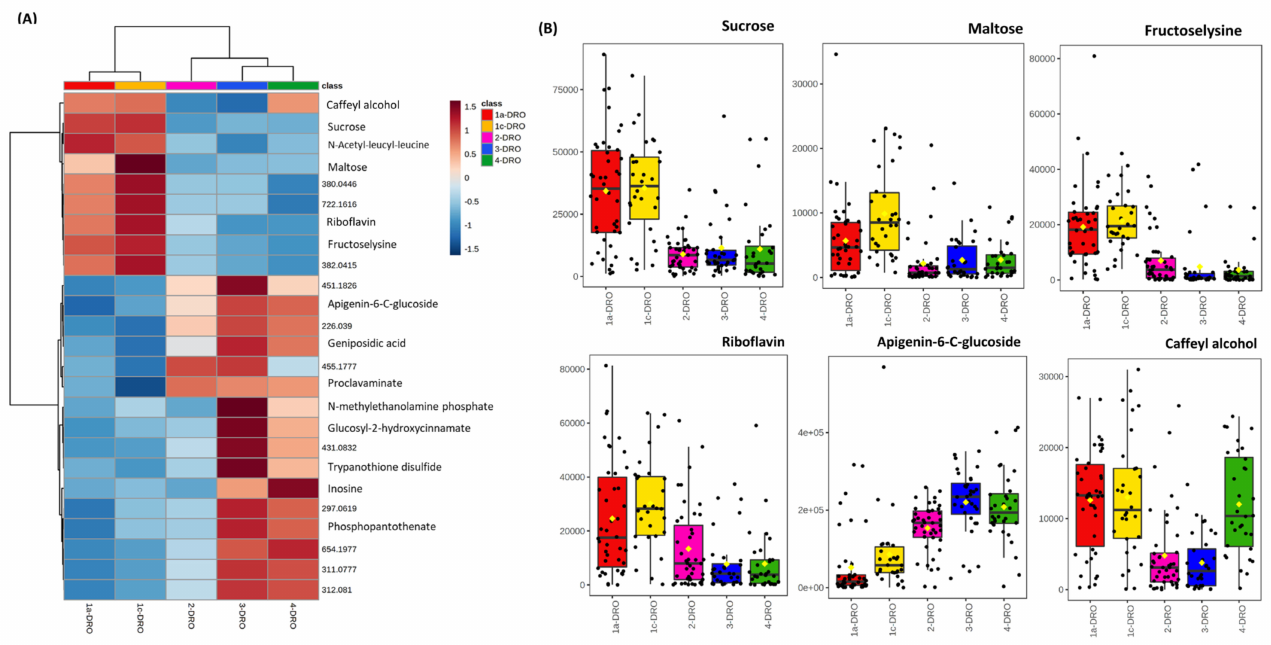
Figure 4. Key variables in the metabolomes of droughted Brachypodium accessions collected from different Turkish regions. Eight-week-old Brachypodium accessions were transferred to the National Plant Phenomics Centre, Aberystwyth, UK. The watering was regulated to achieve three different soil water contents (SWC): 15%, (droughted, DRO) 40% and 75% (control, CON). After 12 days of drought, leaves were sampled and the metabolomes were assessed using FIE-HRMS. The key variables discriminating between the droughted samples were identified by one way ANOVA (corrected for false discovery rates, FDR). ( A ) The relative levels of the m/z are displayed using a heatmap. Some mass-ions ( m/z ) were identified from comparison with databases and are labelled with names. Where m/z could not be identified these are given as the raw data values. ( B ) Box and whisker plot of exemplar metabolites which are increased in the central subpopulation (Turkish climatic region 1a, 1c)